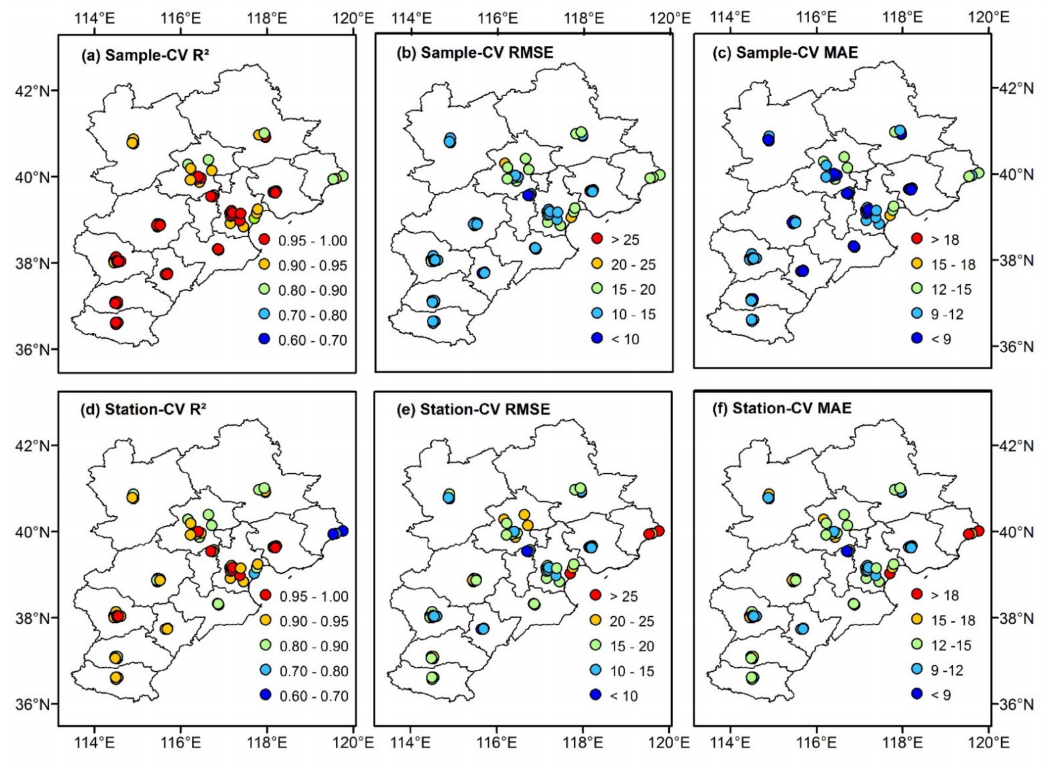
Figure 4. Spatial distributions of the R 2 , RMSE, and MAE of the monitoring sites for sample-based